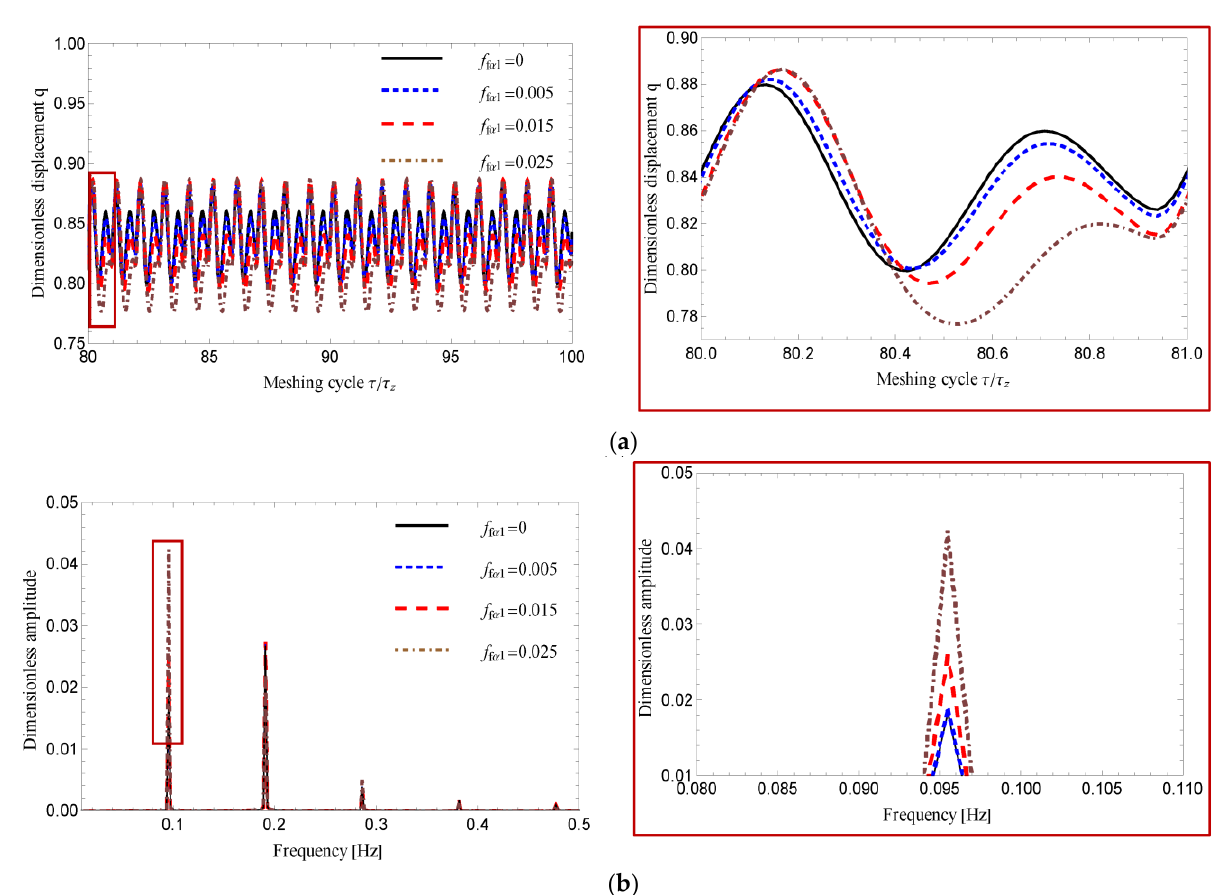
Figure 10. The dynamics characteristics with different 𝑓 𝑓𝛼1 : ( a ) time history diagram; ( b ) FFT spectrogram.